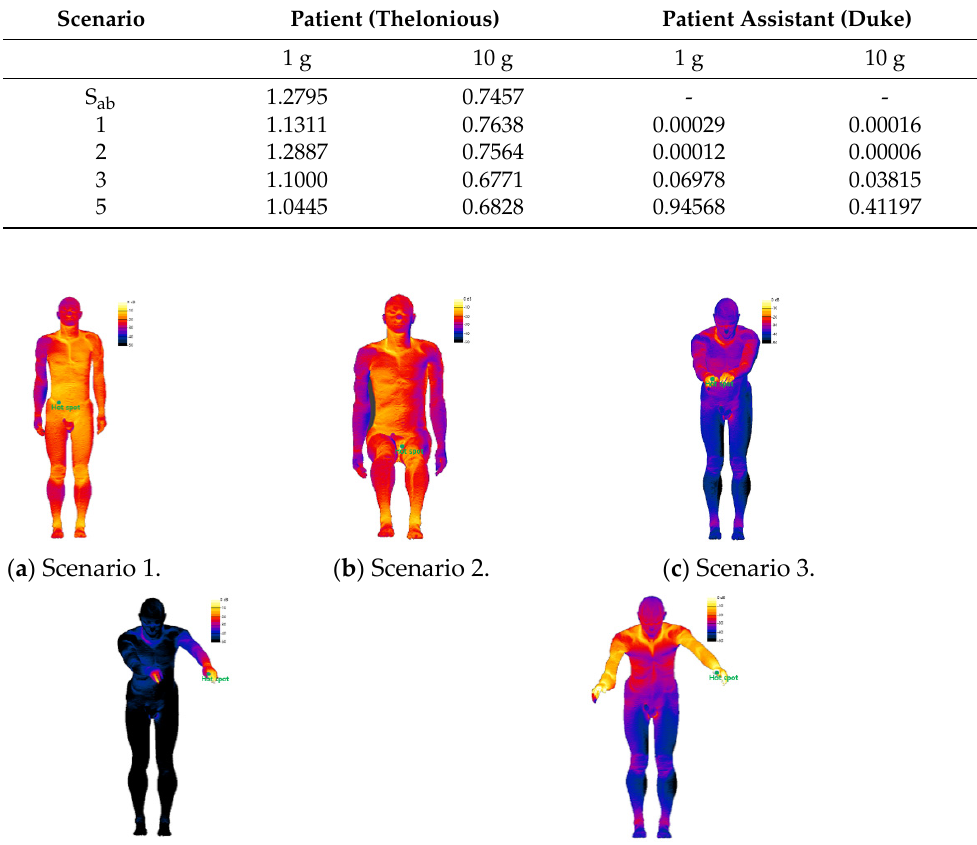
Table 3. Peak spatially averaged SAR (W/kg) in Thelonious (patient) and Duke (patient assistant) according to head RF coil (input power = 1 W). Scenario